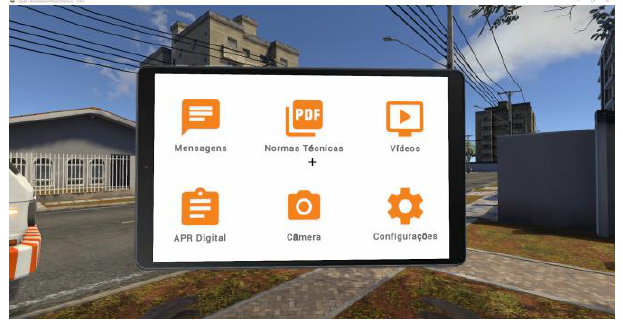
Figure 22. Virtual Tablet main screen.